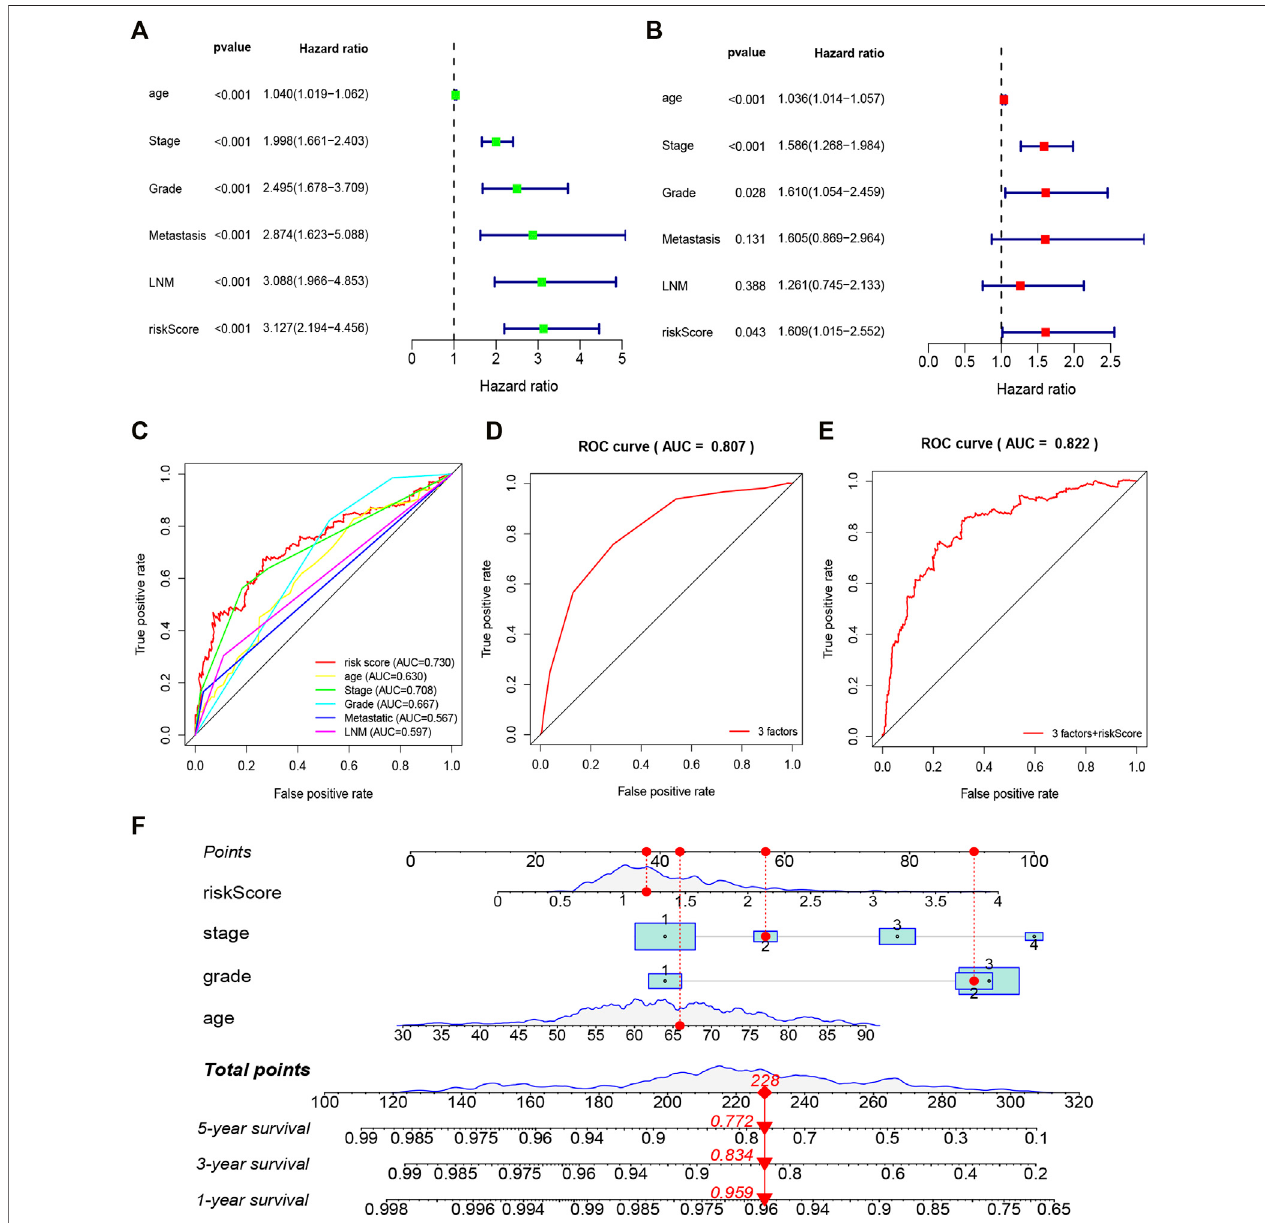
FIGURE5| ForrestplotoftheunivariateandmultivariateCoxregressionanalysisinEC (A) .TheregressionanalysisofoverallsurvivalinEC (B) .ThemultivariateCox regression analysis in EC (C) . ROC curve analysis was performed to evaluate the diagnostic ef fi cacy of the gene signature and other clinical characteristics (D,E) . ROC curveanalysiswasperformedtoevaluatethediagnosticef fi cacyofthethreefactors(age,grade,andstage)andthreefactors+riskScore (F) .Nomogramisusedtoshow the relationship between the variables in the prediction model and predict the 1 – 5 years overall survival rate of patients.